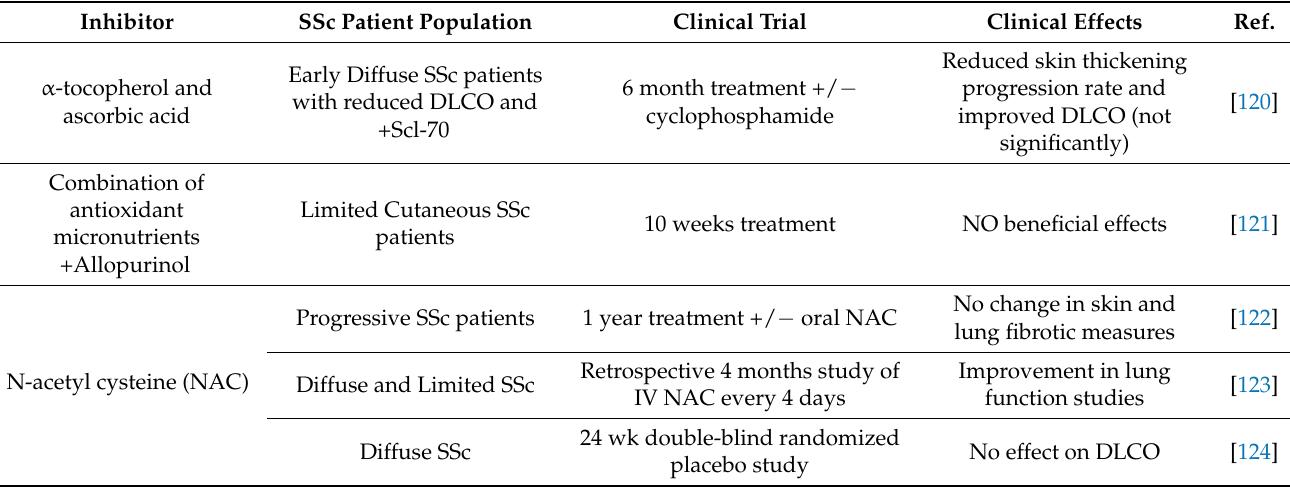
Table 2. Clinical Studies of Oxidative Stress Inhibitors in SSc Patients.